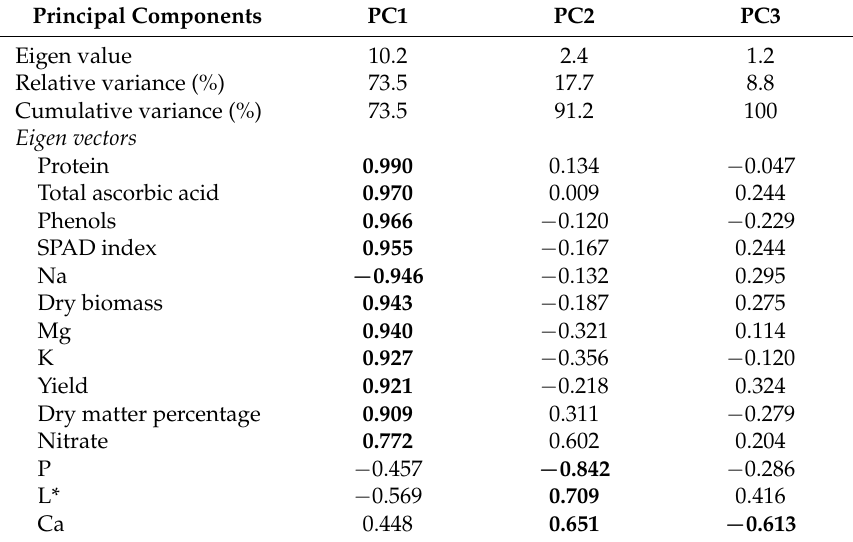
Table 4. Eigenvalues, relative and cumulative percentage of total variance, and correlation coefficients for each spinach trait with respect to the two principal components (PC1 and